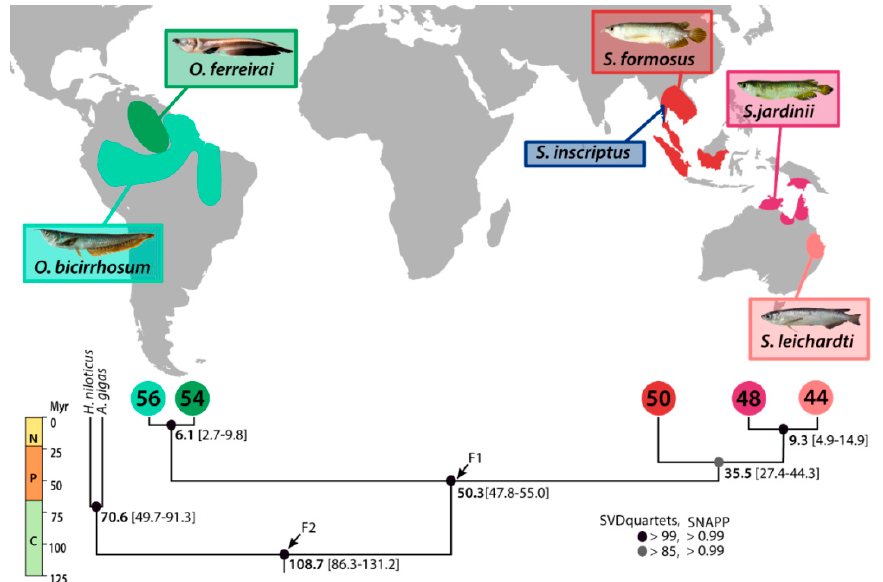
Figure 1. The geographic distribution of arowana, showing species color-coded by potential occurrence in South America ( O. bicirrhosum , light green; O. ferreirai , dark green), Asia ( S. formosus , red; S. inscriptus , blue), and Australia ( S. jardinii, dark pink; S. leichardti , light pink). The consensus dated species tree given by SNAPP is shown, with estimated (average) divergence time in bold and 95% highest posterior density (HPD) intervals inside brackets for each node. Support is coded using circles in each node, and fossil calibrated nodes are indicated by arrows. Circles in the tips represent each species, with the same color used in the map, and numbers inside the circles represent the diploid chromosome number (2 n ) for each species. A geological scale with the main periods is depicted on the left (N = Neogene; P = Paleogene; C =